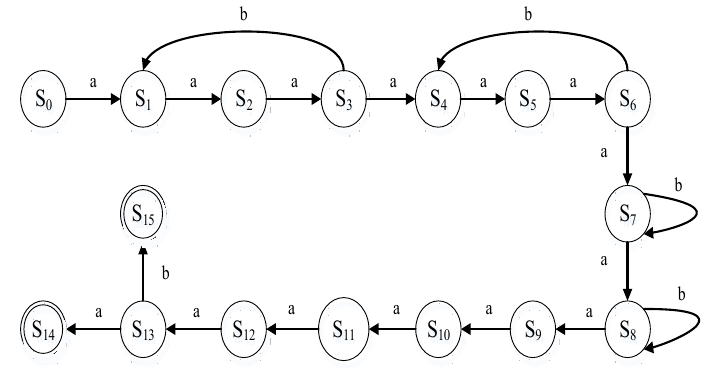
Figure 5. The FSM model of a ring signature.